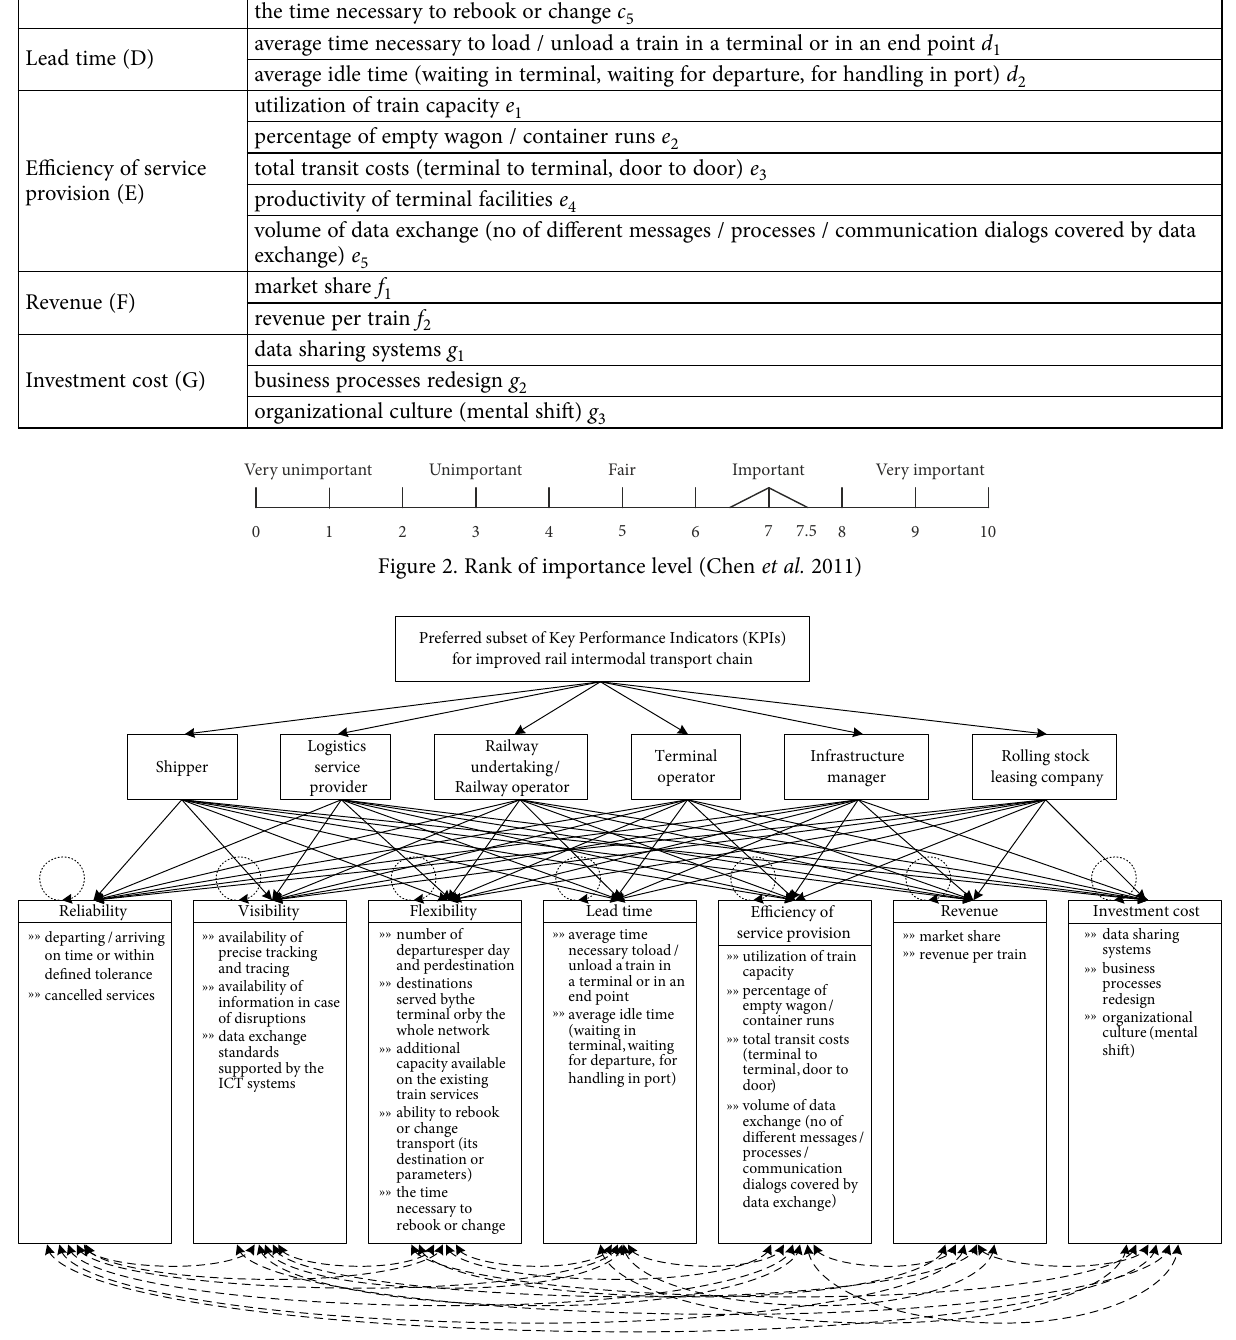
Figure 3. Network structure for prioritizing the set of values associated with rail-enabled information sharing platform